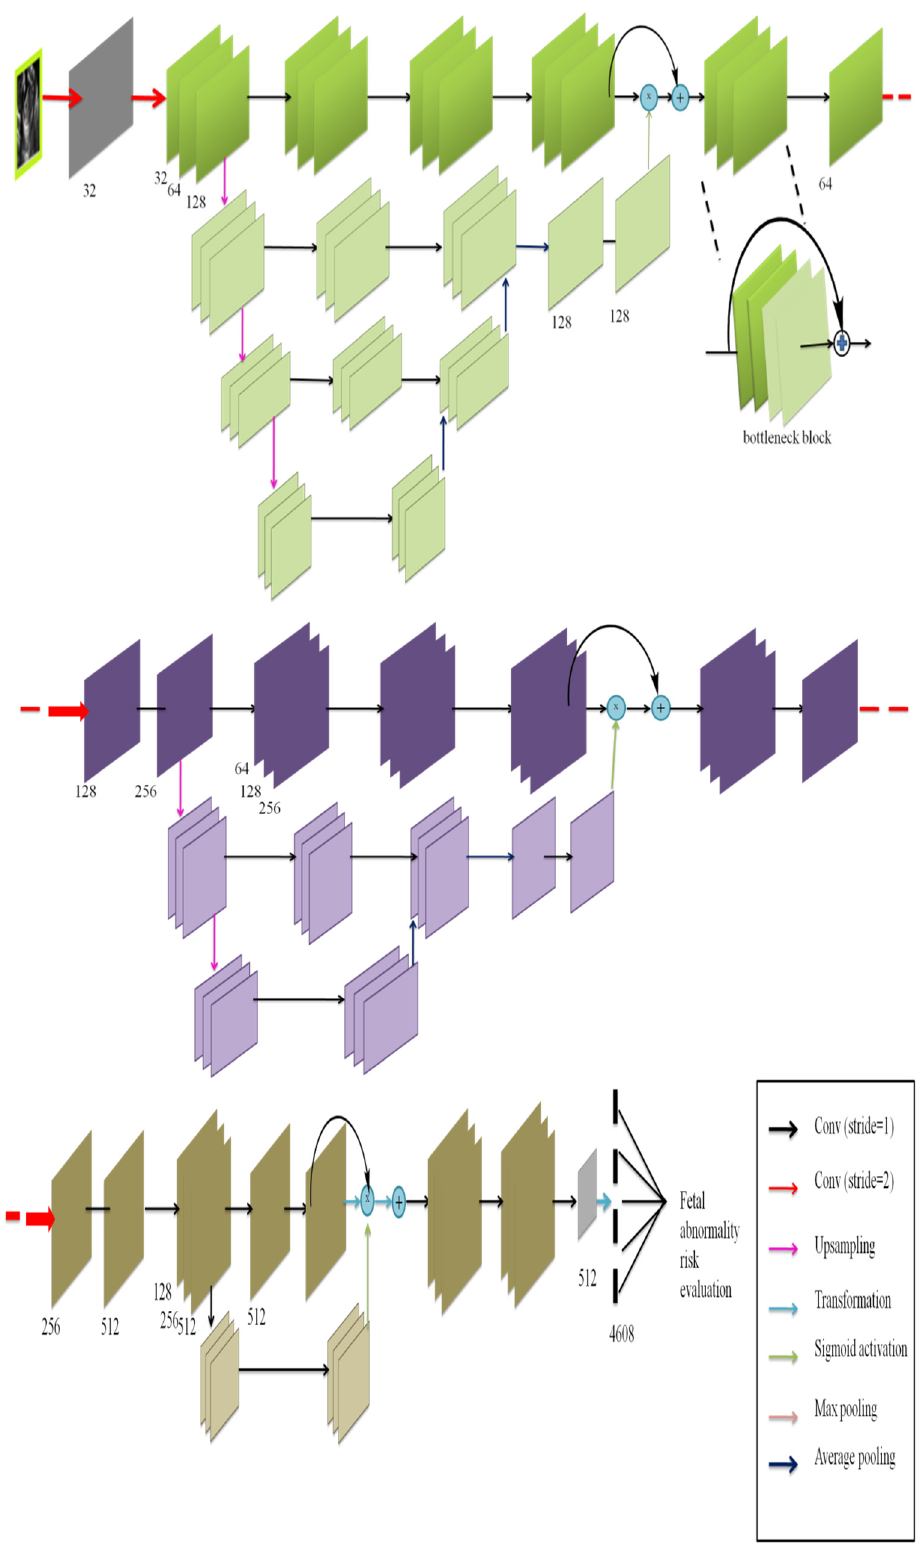
Figure 5. Illustration of the proposed